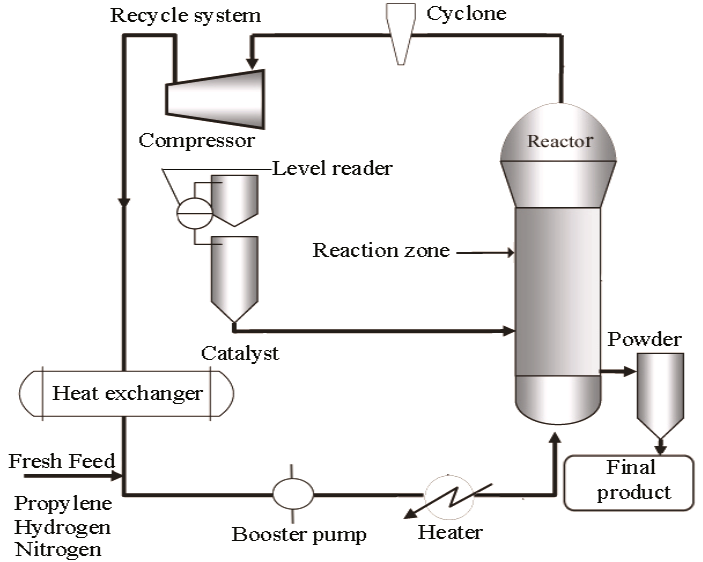
Figure 1. Schematic diagram of fluidization of the polypropylene production